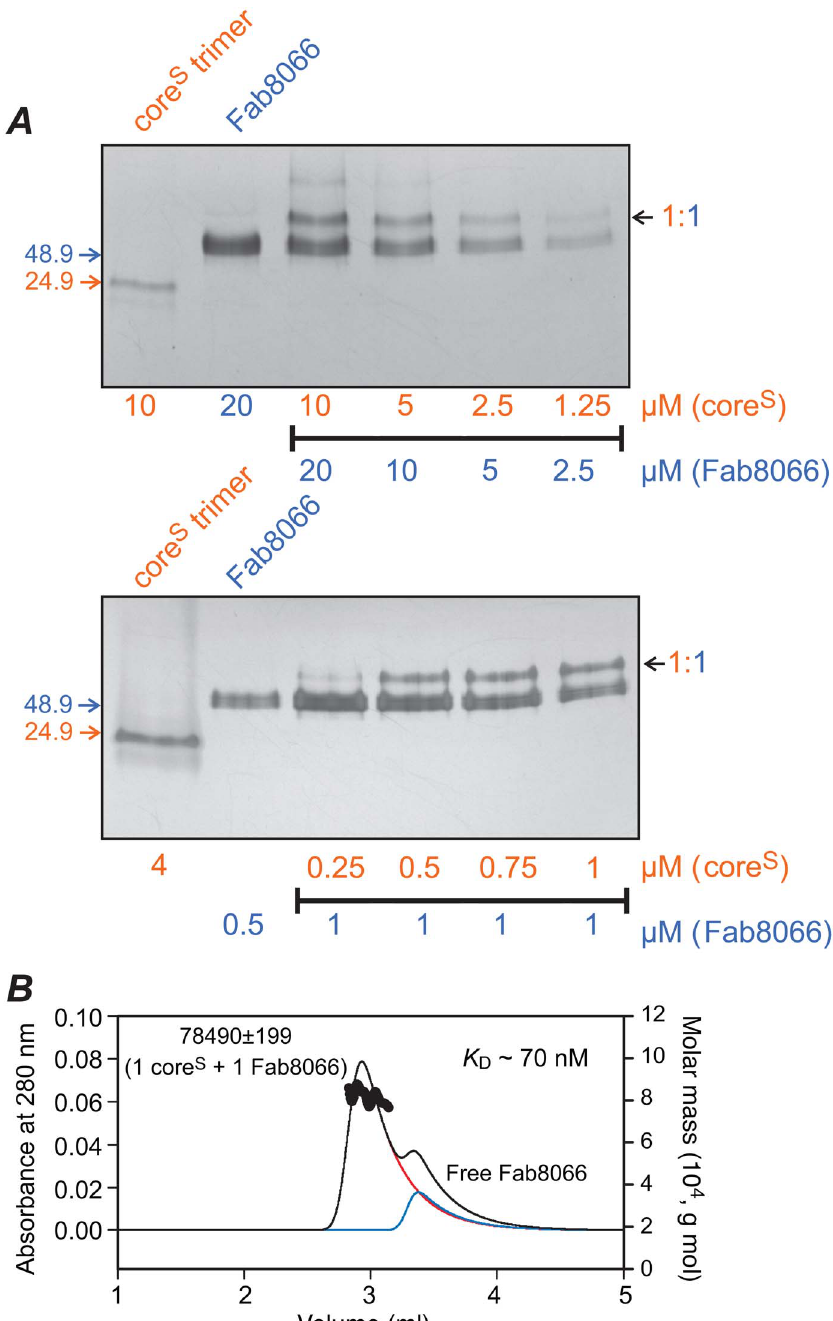
Figure 6. Determining the upper limit of affinity for the binding of Fab8066 to core S by native-PAGE and an approximate K D by SEC-MALS. ( A ) Decreasing concentrations (10 to 1.25 m M) of core S trimer mixed with a 2-fold molar excess of Fab8066 and subjected to native-PAGE with Coomassie staining (upper panel), and decreasing concentrations (1 to 0.25 m M) of core S trimer mixed with a constant 1 m M concentration of Fab8066, visualized by silver staining. Core S and Fab8066 are color coded orange and blue, respectively. ( B ) Injection of 3 m g core S mixed with 6 m g Fab8066 on a BioSep-SEC-S 2000 column(0.46 6 30 cm) at a flow-rate of 0.35 ml/min equilibrated in10 mMTris-HCl, pH 7.6, 150 mMNaCl (bufferA). The elution profile (black) is shown superimposed on deconvoluted peaks for the major ( , 85%) core S -Fab8066 complex (red) and free Fab8066 (blue). The measured mass of the complex is shown beside the peak. A K D of , 70 nM was estimated on the basis of the calculated concentration of the complex and free Fab. Deconvolution of the SEC-MALS profile was carried out using the program PeakFit (Seasolve Software, Inc. Framingham, MA). doi:10.1371/journal.pone.0104683.g006 and Sc66 to 6-helix bundle mimetics, and therefore the mode of with pre-hairpin intermediate mimetics [35,36] to avoid steric interaction of these antibodies with the 6-helix bundle mimetics clash between the CDR-H1 and CDR-H2 loops of the antibodies must be slightly different from that observed by crystallography and one of the C-HR helices (Fig. 2C).